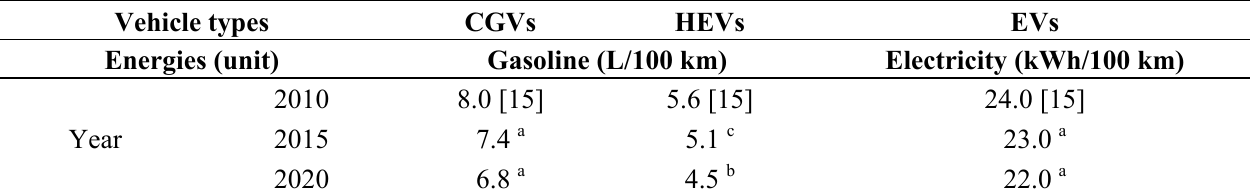
Table 3. Energy consumption for a single vehicle in China.